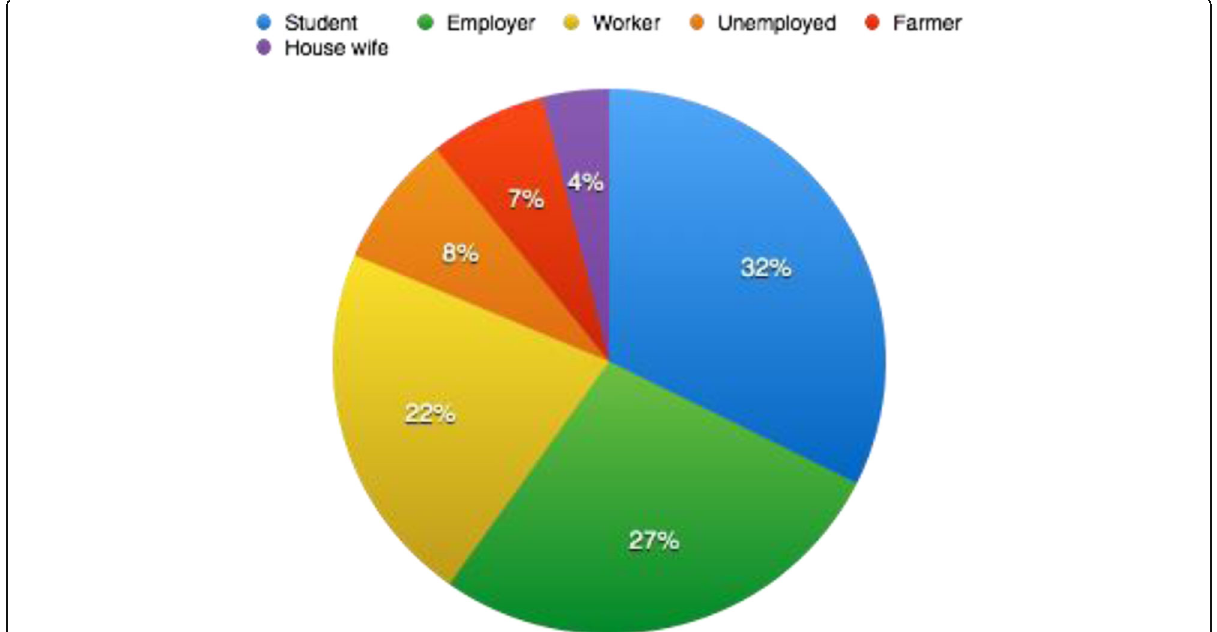
Fig. 1 The distribution of injured by their social status in